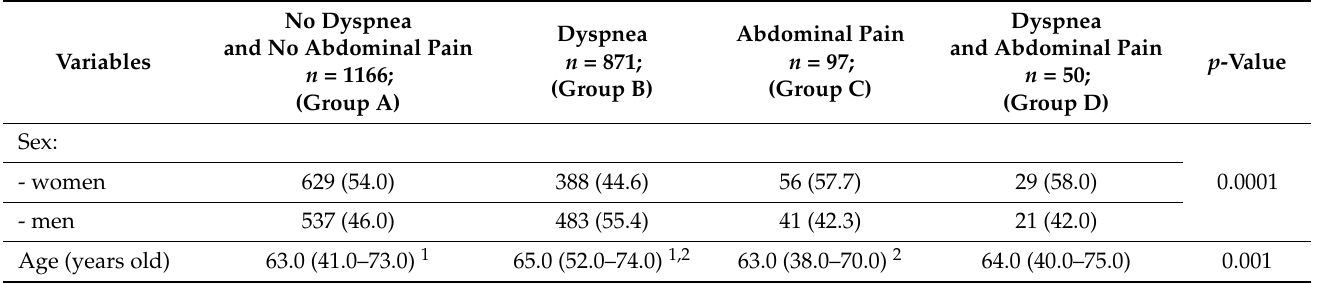
Table 1. Baseline characteristics of 2184 patients hospitalized due to COVID-19, divided into four study groups.